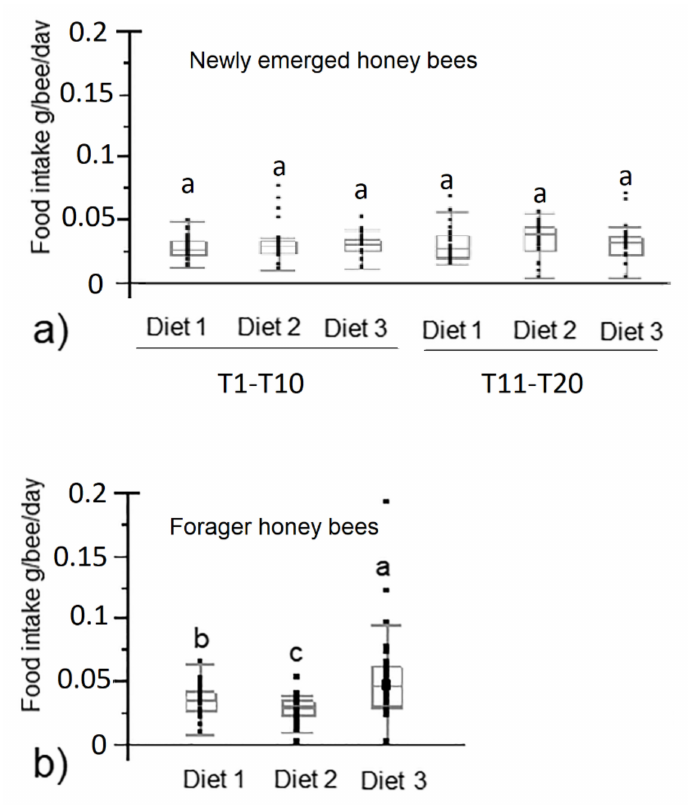
Figure 1. Feed intake of newly emerged from T1 to T10 and from T11 to T20 ( a ) and forager honey bees ( b ) fed with control diet and experimental diets (diet 1, diet 2, diet 3 with 0.3%, 1.7% and 7.7% of protein content, respectively). Different letters indicate statistical significance ( p < 0.01) by Kruskal–Wallis